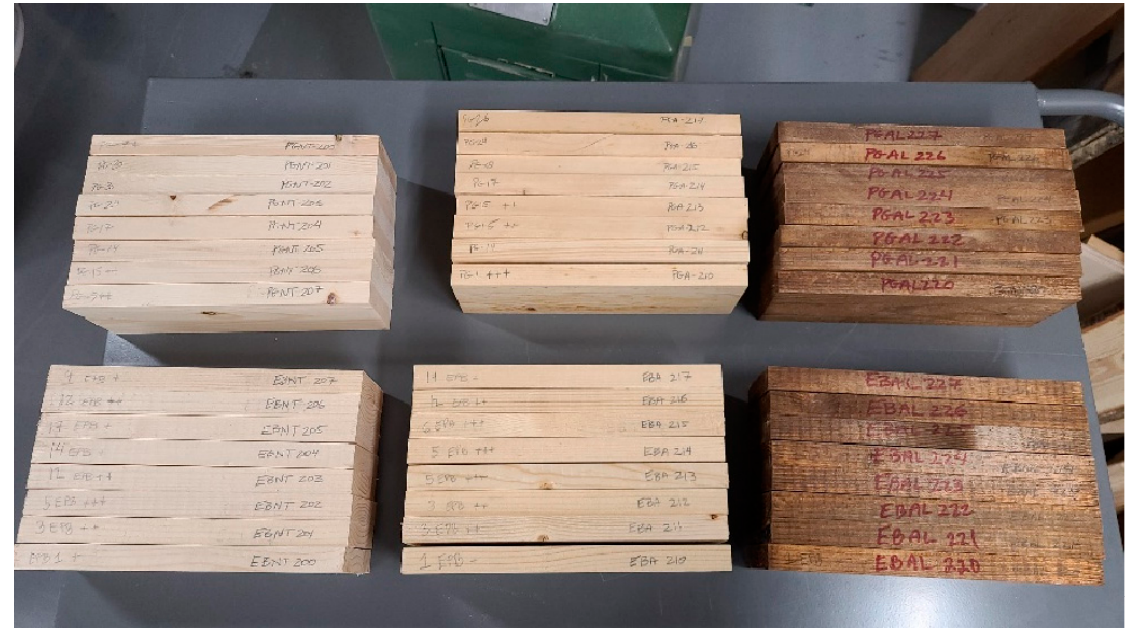
Figure 1. White spruce wood control, treated by organosilanes alone and treated with organosilanes and aluminum (from left to right).